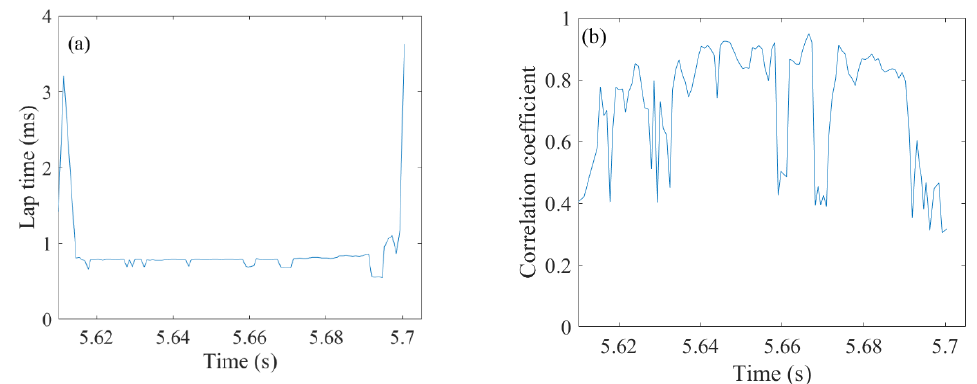
Figure 7. Autocorrelation results of B10 (5.61–5.71 s): ( a ) lap time and ( b ) correlation